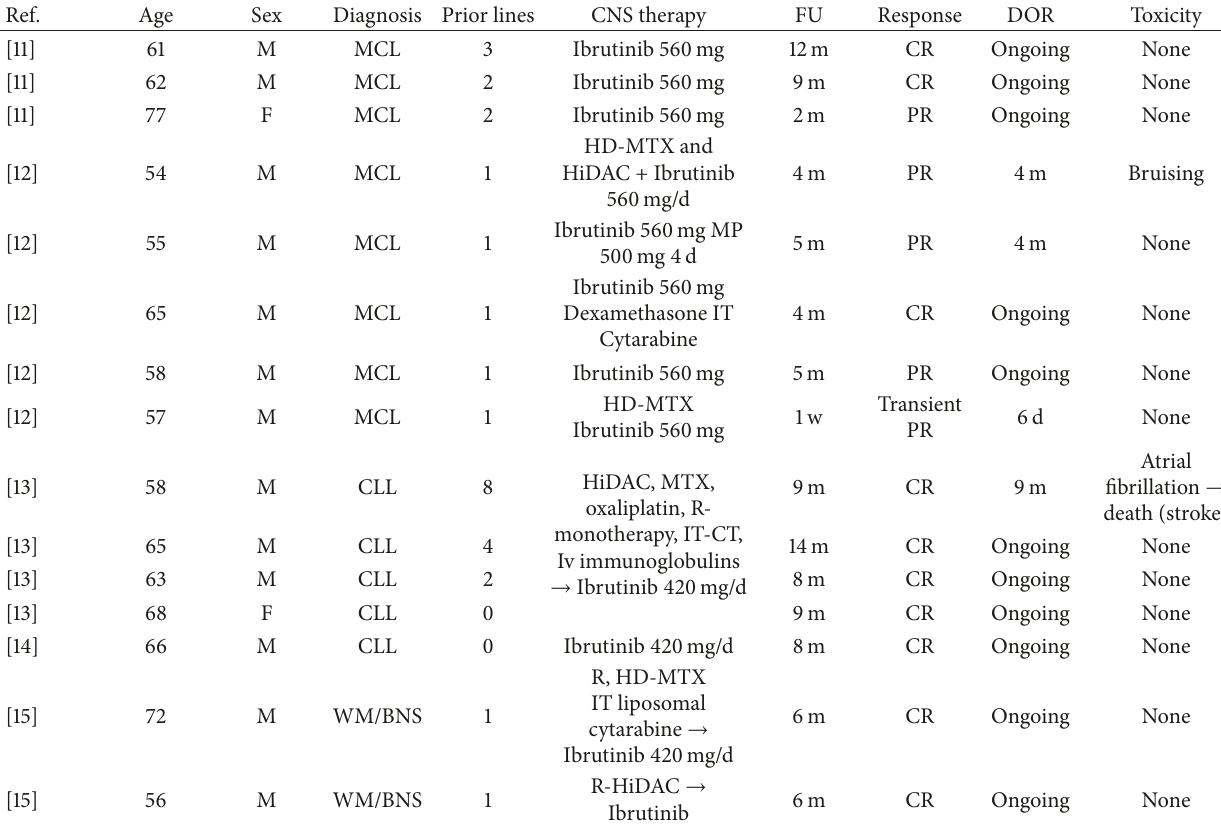
Table 1: Review of ibrutinib therapy for patients with LPD and CNS involvement.